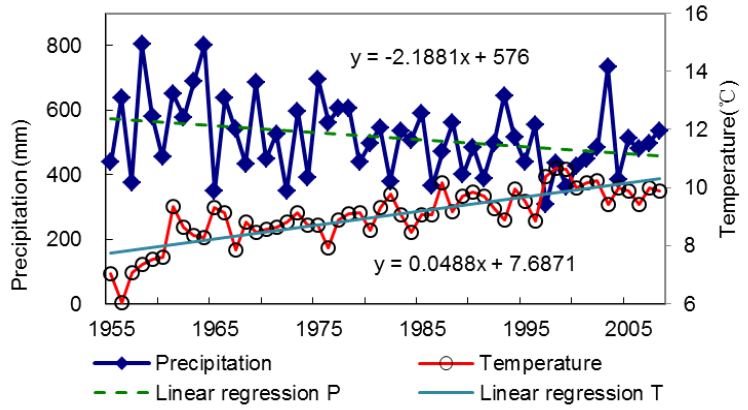
Figure 2. Variations in annual precipitation and temperature of the Xinshui River catchment for 1955– 2008.